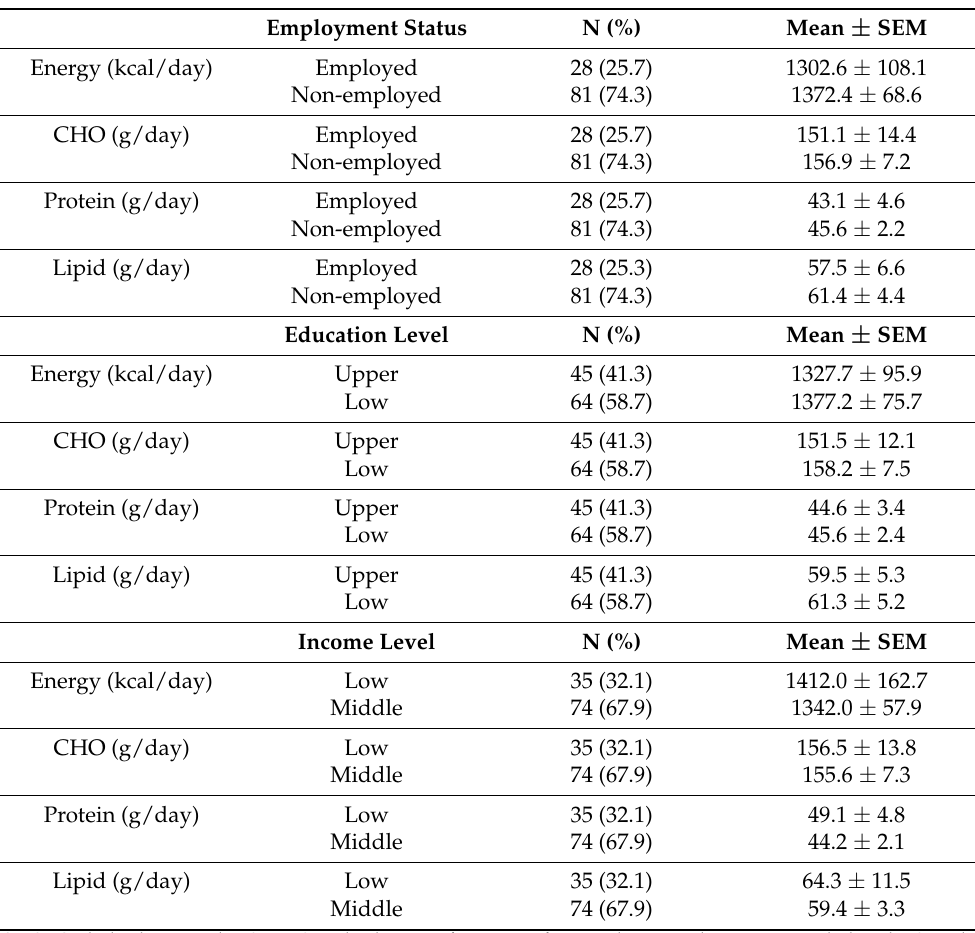
Table 2. Maternal employment status, education and income levels of mothers vs. energy and macronutrient (Carbohydrate, Protein and Lipid) intake of their preschool